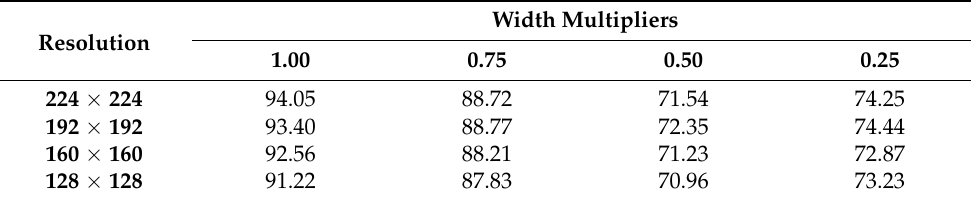
Table 4. Accuracy of MobileNets on every combination of resolution and width multipliers.